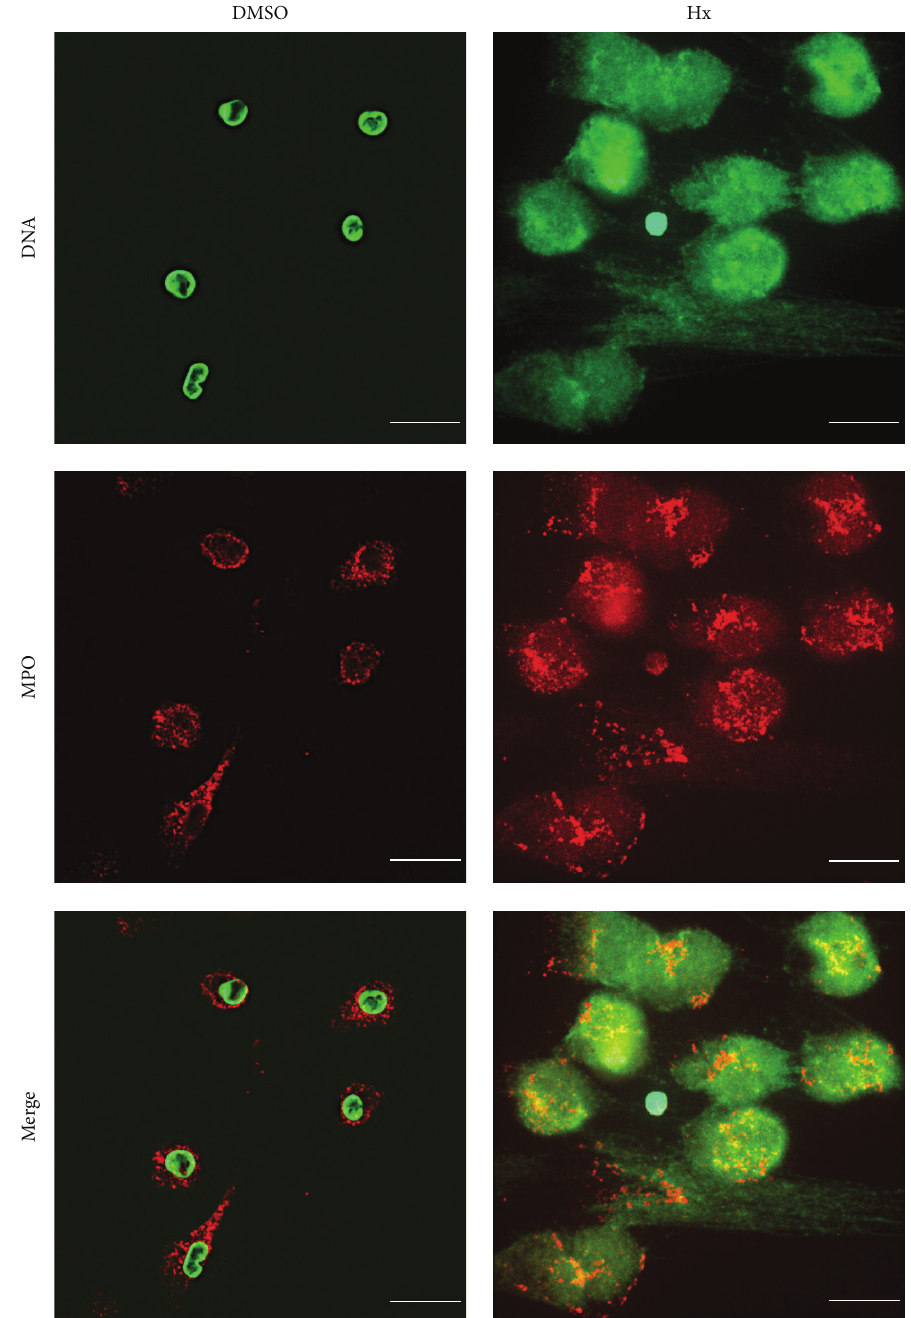
Figure 2: Hepoxilin A3 induces NETosis. Four hours after stimulation with either vehicle or HxA3, cells were fixed and stained for immunofluorescence analysis. Cells were stained for DNA (green) and MPO (red) after activation with HxA3 (5 𝜇 g/mL). Images are representative of 3 independent